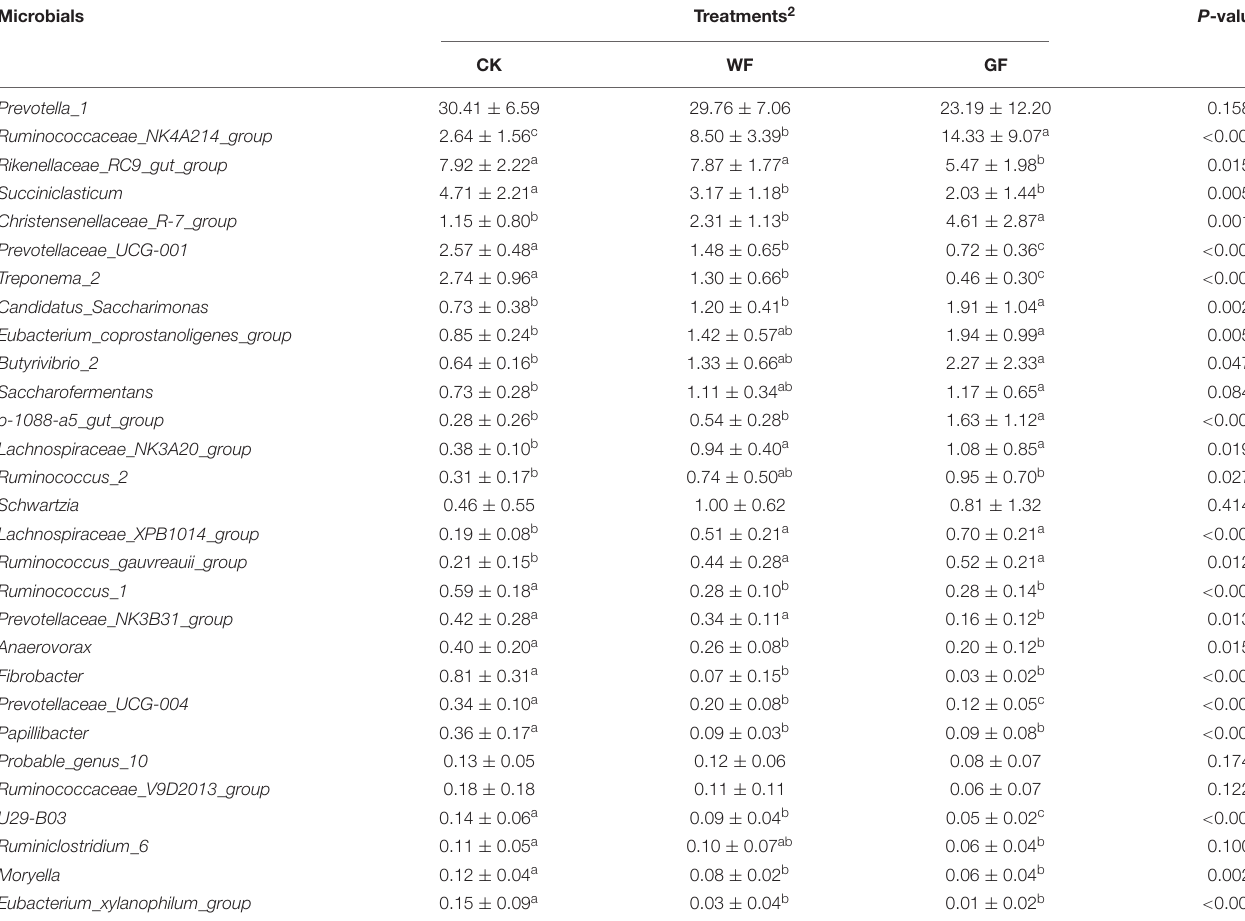
TABLE 5 | Effects of dietary whole and ground flaxseed supplementation on rumen bacterial genera 1 .